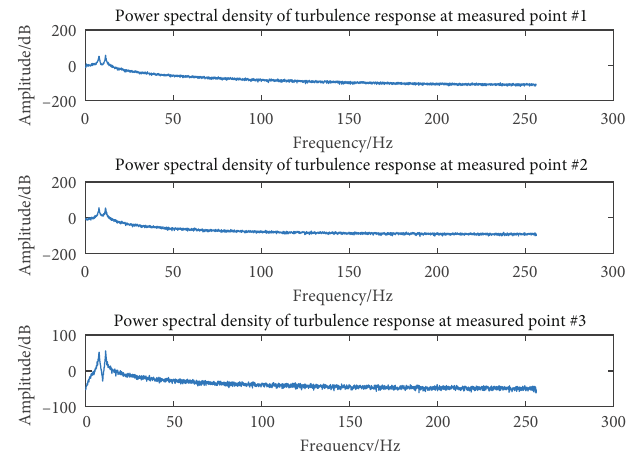
Figure 6: PSD of the two-mode turbulence response.